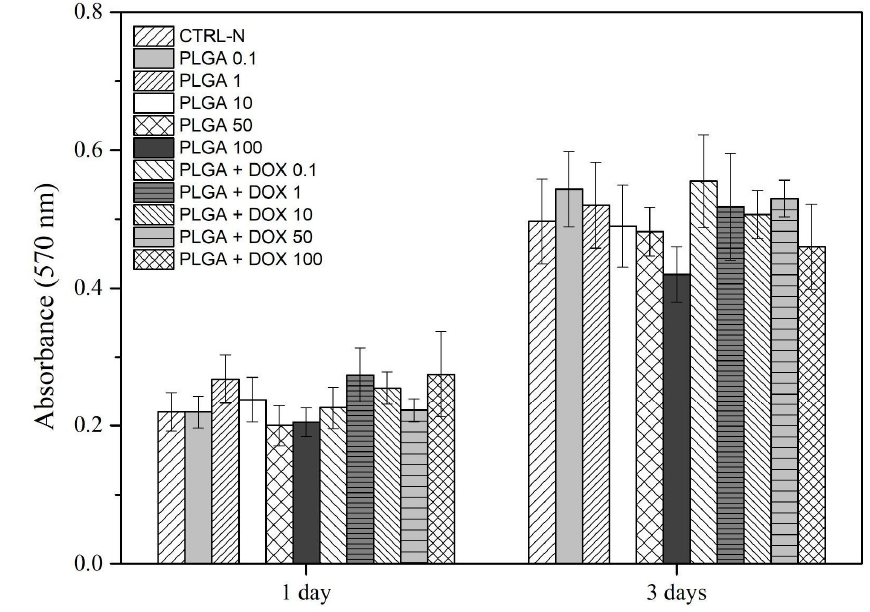
Figure 8. Absorbance detected by the MTT reduction colorimetric assay; mean values and standard deviation of mesenchymal stem cells cultured for 1 and 3 days in DMEM medium containing several concentrations of PLGA and PLGA + DOX.